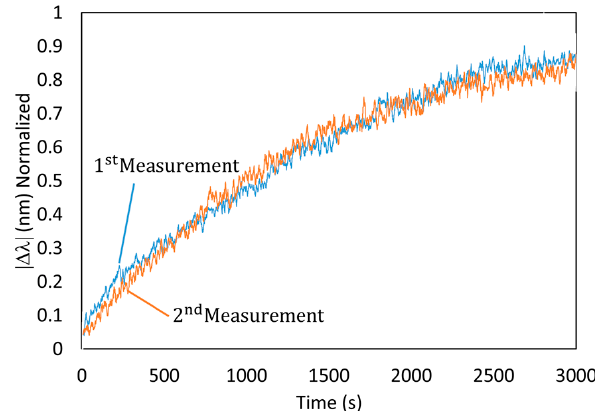
Figure 9. Regeneration of the optical fiber sensor. Repeatability of the sensor under 20 ppb of mercury after its regeneration in a dilute nitric acid solution. The final wavelength-shift is very similar in both cases, and the response slope is even more stable.